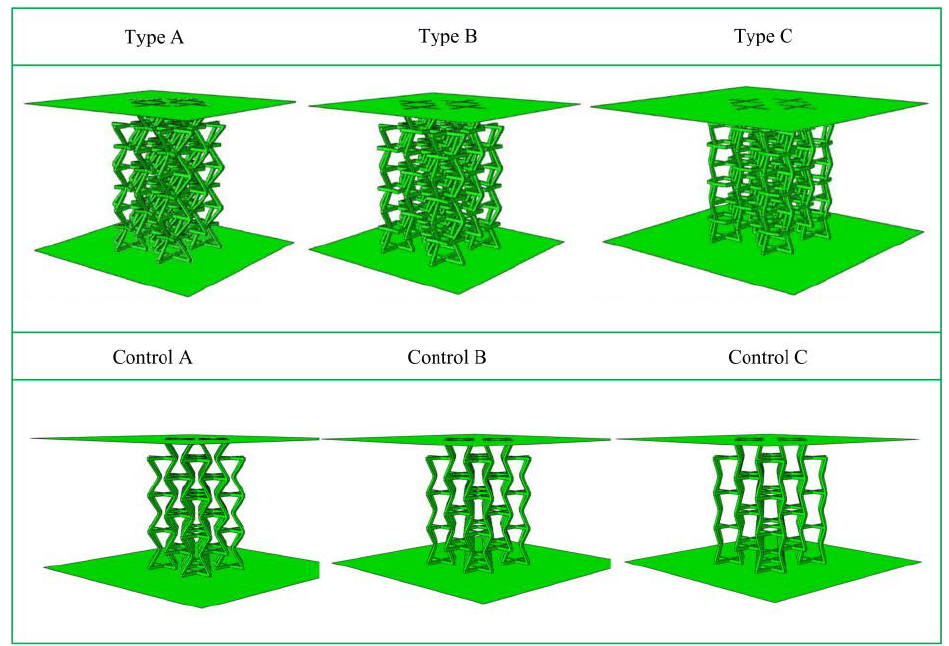
Figure 10. Schematic diagrams of six models for numerical simulation.